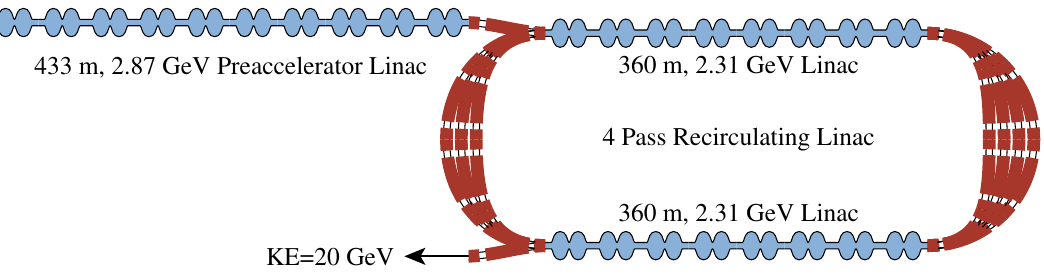
FIG. 21. (Color) Accelerating system layout.